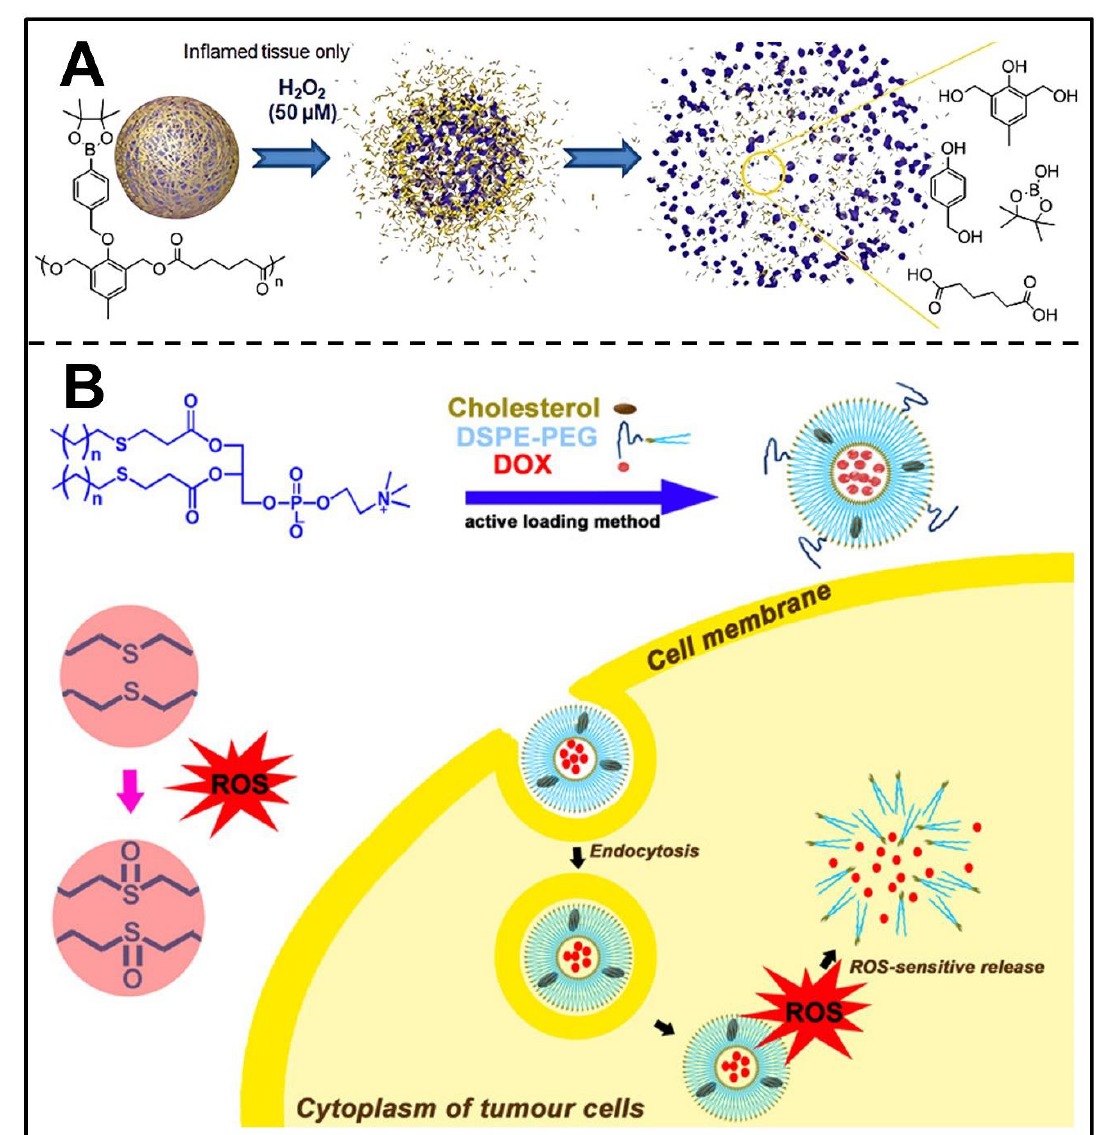
Figure 7. Design and responsive mechanism of ROS-triggered srNPs. ( A ) Composite and H 2 O 2 -degradable mechanism of polymeric nanoparticles. Reproduced with permission [133]. Copyright 2012, American Chemical Society. ( B ) Formulation and ROS-induced DOX release of S-LPs. Repro- duced with permission [136]. Copyright 2019, American Chemical Society.